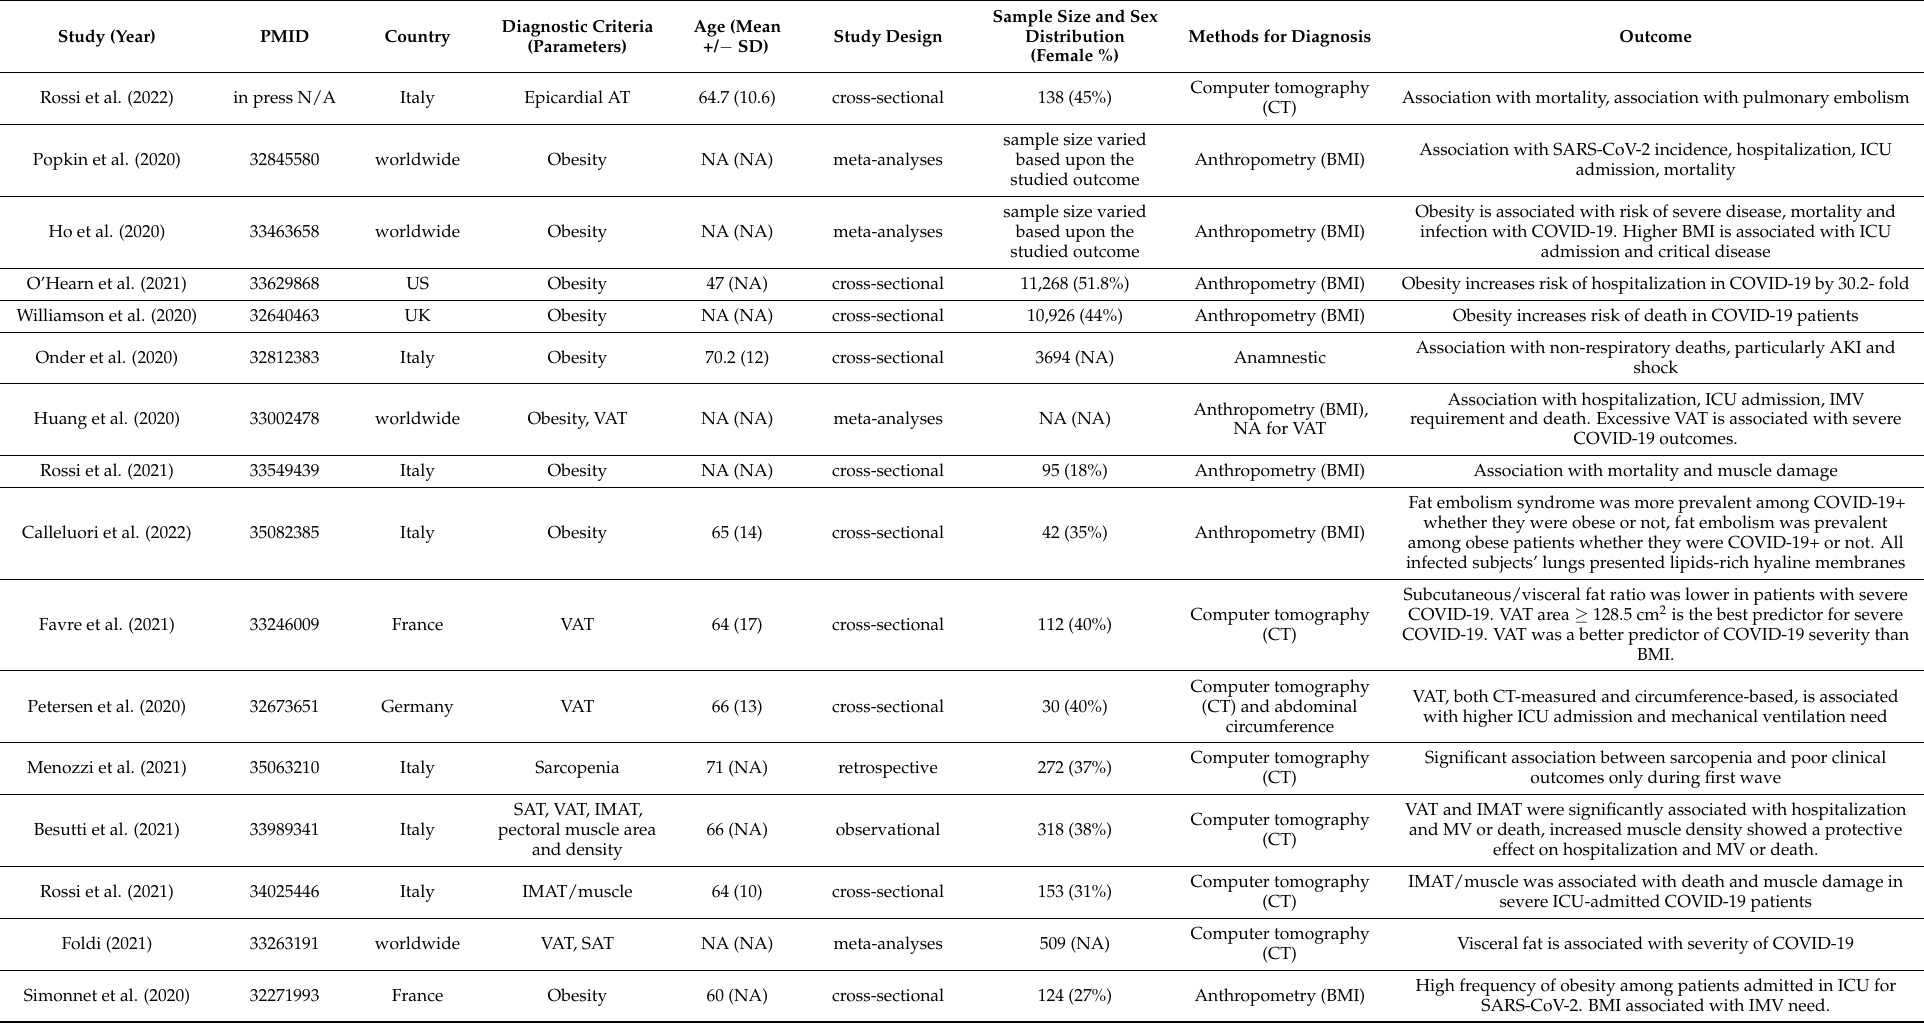
Table 1. Studies investigating the relationship between different body composition components and clinical outcomes included in the narrative